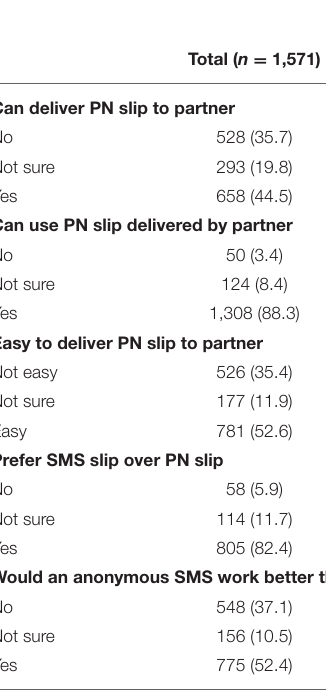
TABLE 3 | Partner notification practices of